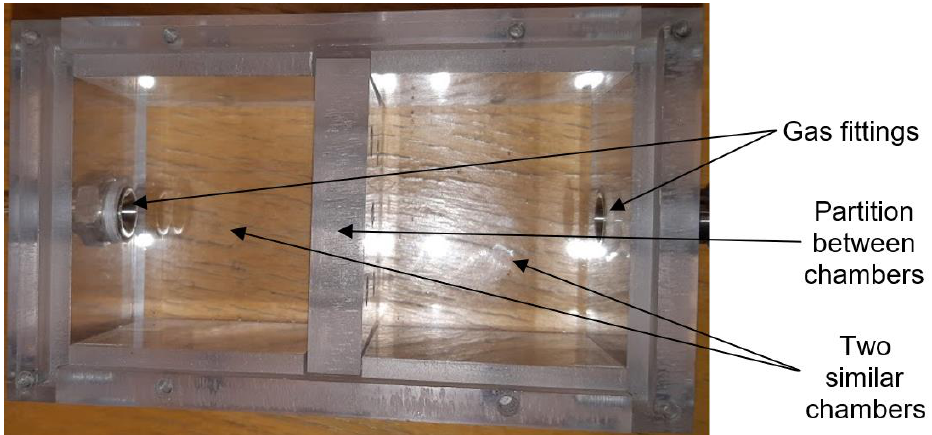
Figure 4. Photo of testing chamber for commercial sensors (top view).